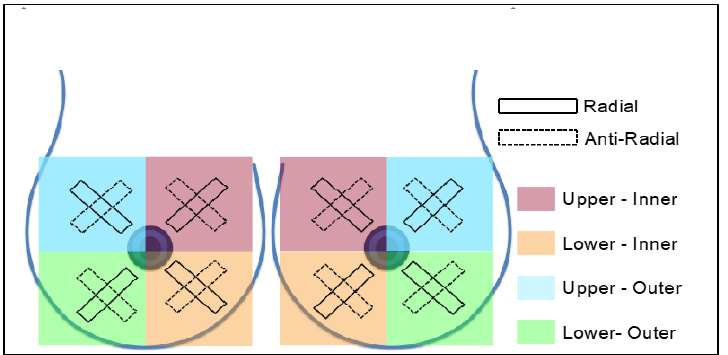
Figure 1. Schematic of transducer positions used to obtain shear-wave speed ( c s ) estimates from the breast. Eight B-mode image and elastogram pairs were acquired from each breast.